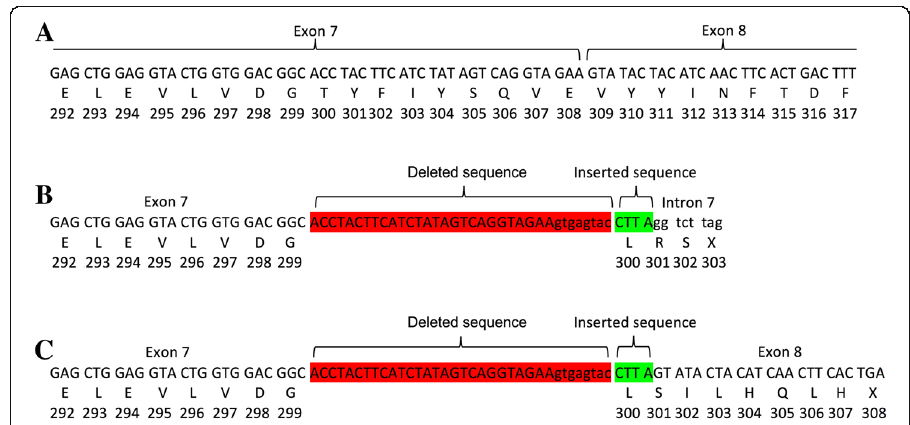
Fig. 4 The frameshift mutation in the end of exon 8 (c.898_924+ 8del35ins4CTTA) on EDA gene makes an early termination in amino acid production, which is